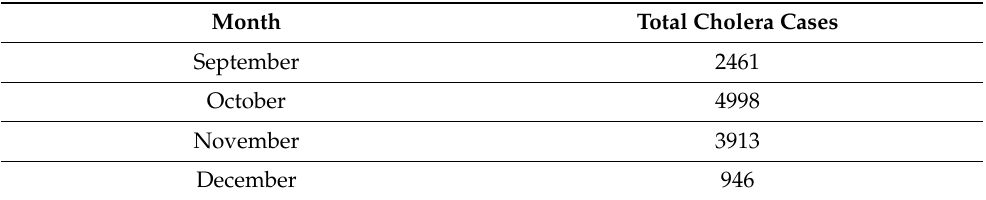
Table 3. Total reported cholera cases per month [69].